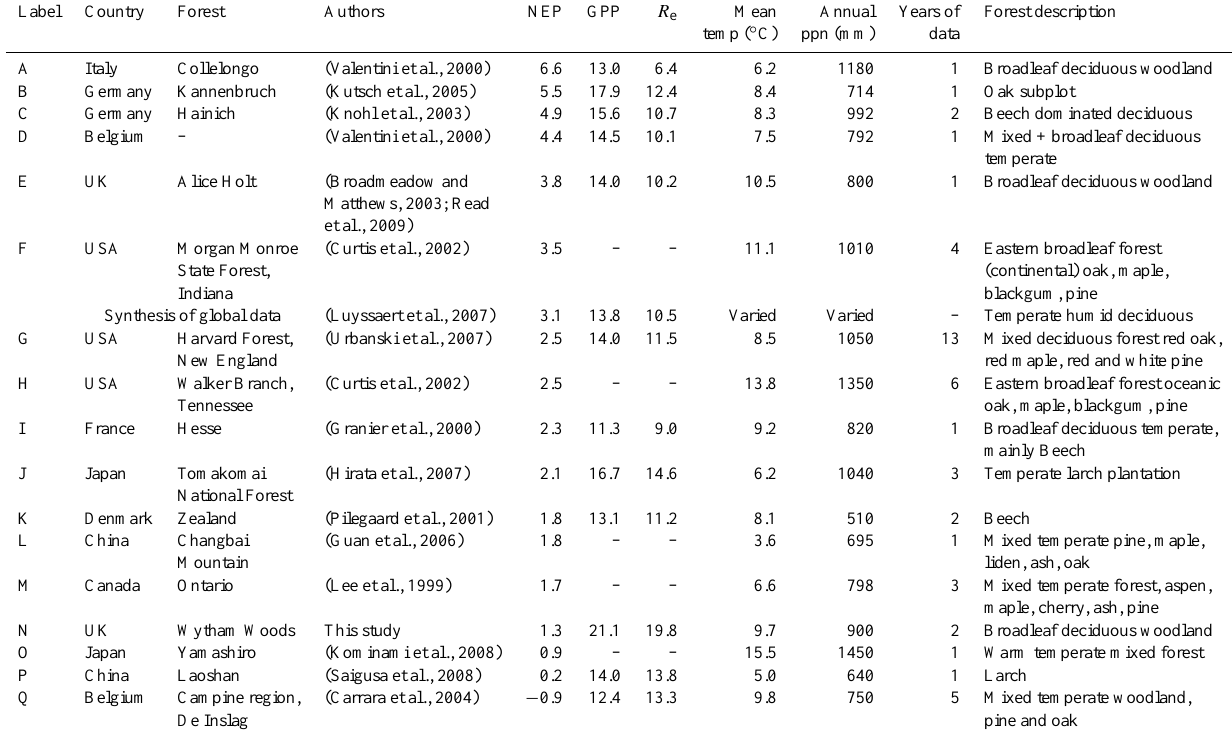
Table 4. Collection of flux data from temperate deciduous or semi deciduous woodland across the globe. NEP, GPP and R e in MgCha − 1 yr − 1 . NEE used where NEP